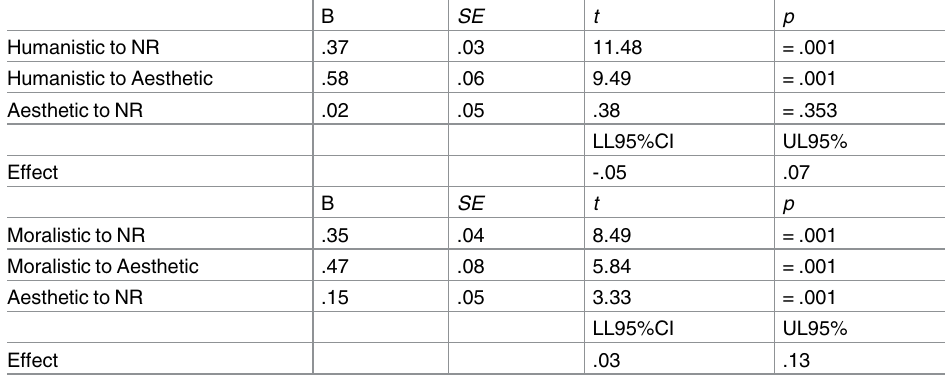
Table 14. Simple mediation of the indirect effectsof engaging with humanistic and moralistic indica- tors on nature connectedness (n = 118; 5000 bootstrap samples). B SE t p Humanistic to NR .37 .03 11.48 = .001 Humanistic to Aesthetic .58 .06 = .001 Aesthetic to NR .02 .05 .38 = .353 -.05 .07 Moralistic to NR .35 .04 = .001 Moralistic to Aesthetic .47 .08 5.84 = .001 Aesthetic to NR .15 .05 3.33 = .001 .03